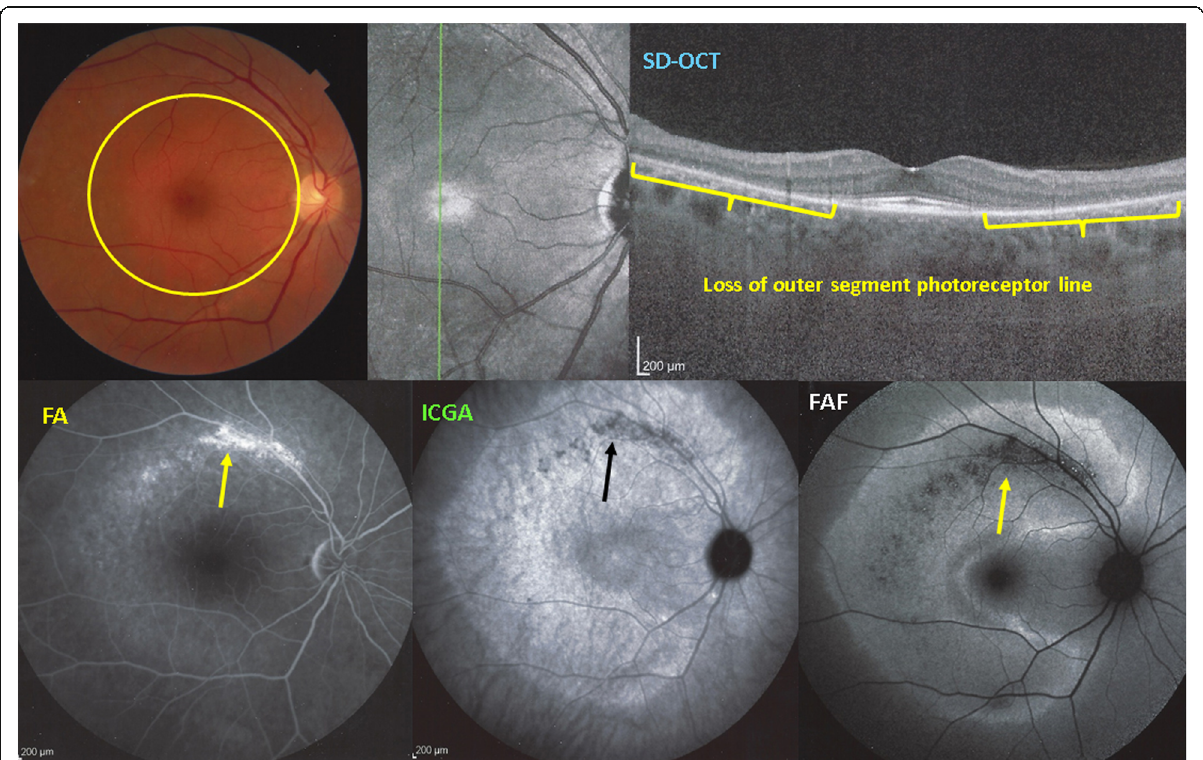
Fig. 16 Example of AZOOR, a true primary phoreceptoritis with Imaging illustration of its clinicopathology. Fundus shows a pale discoloured halo around the fovea which retains a normal colour (top left, yellow circle) due to loss of photoreceptor photopigment. FA (bottom left picture) shows the same halo of discreet hyperfluorescence due to photopigment loss and an area of bright hyperfluorescence (window effect) along superior temporal arcade due to chorioretinal atrophy (dark on ICGA - bottom middle- and FAF – bottom right). ICGA (bottom middle) shows preserved choriocapillaris (except in the arciform area of chorioretinal atrophy) with increased fluorescence in the area of loss of the screen of photopigments which explains also fundus hyperautofluorescence (bottom right). SD-OCT (top right) shows the loss photoreceptor outer